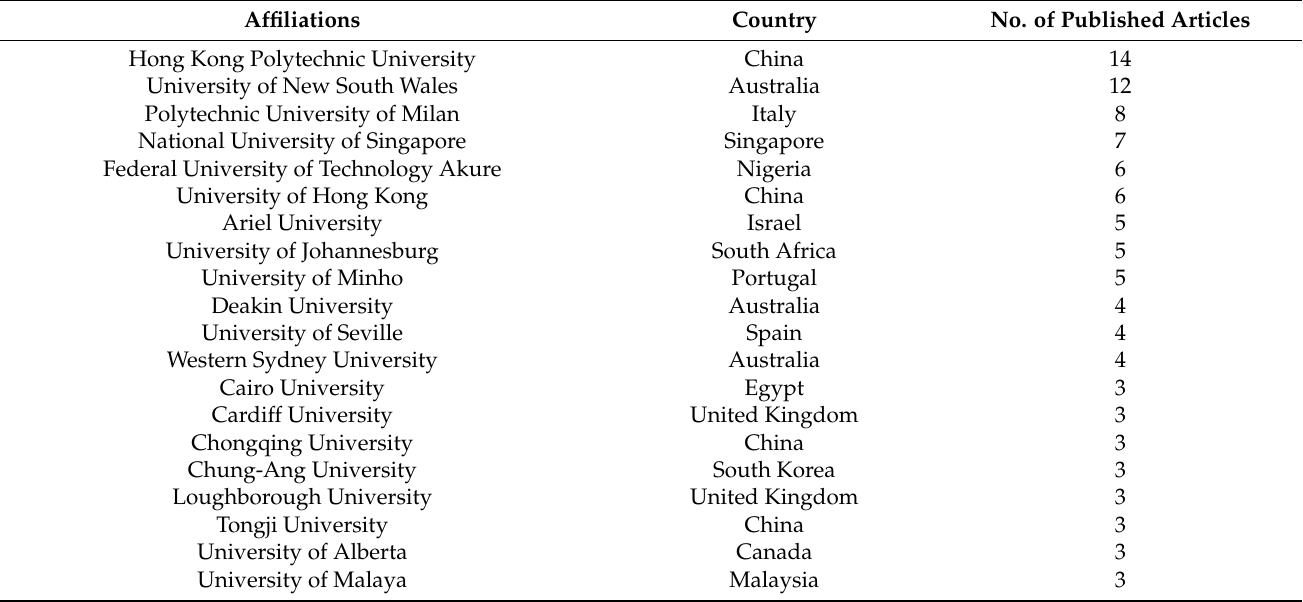
Table 7. Top 20 contributing